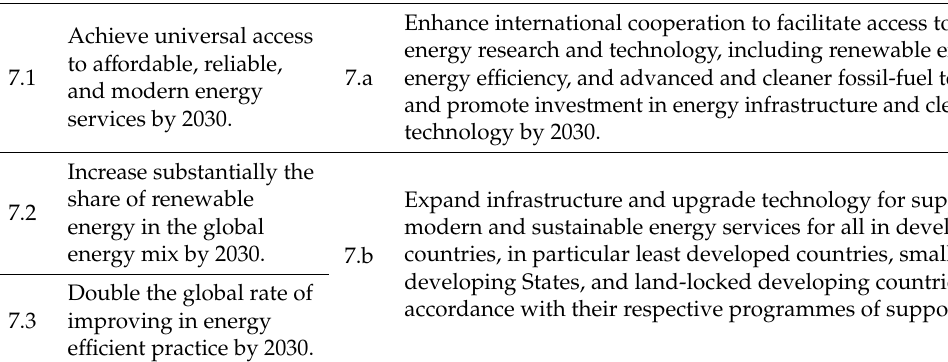
Table 1. All the five energy targets consisting of three substantive targets and two additional targets which are identified as a means of implementation in contributing towards achieving Sustainable Development Goal (SDG) No. 7